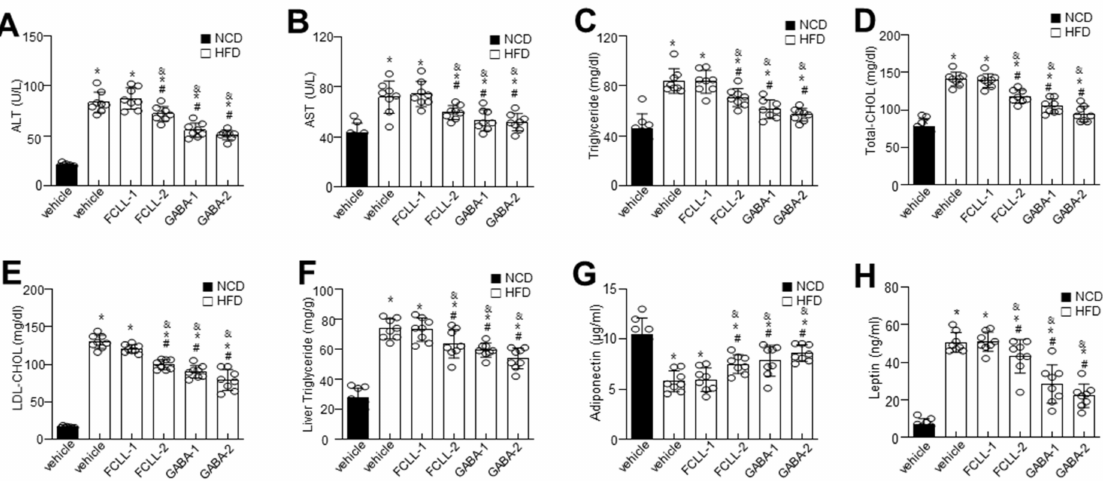
Figure 3. Influence of GABA and fermented Curcuma longa L. extract enriched with GABA on serum biochemicals profile and lipid accumulation. Mice were fed with NCD or HFD with vehicle or GABA and fermented Curcuma longa L. extract enriched with GABA (1 or 2 g/kg) once daily for 14 weeks by oral gavage. Biochemical analyses of serum samples. Levels of ALT ( A ), AST ( B ), Triglyceride ( C ), Total cholesterol ( D ), LDL-cholesterol ( E ), liver triglyceride ( F ), adiponectin ( G ), and leptin ( H ). Data are presented as mean ± SEM ( n = 8, * p < 0.05 vs. NCD + vehicle, & p < 0.05 vs. HFD + FCCL-1, # p < 0.05 vs. HFD + vehicle). NCD, normal chow diet; HFD, high-fat diet; FCLL-1 and FCLL-2,